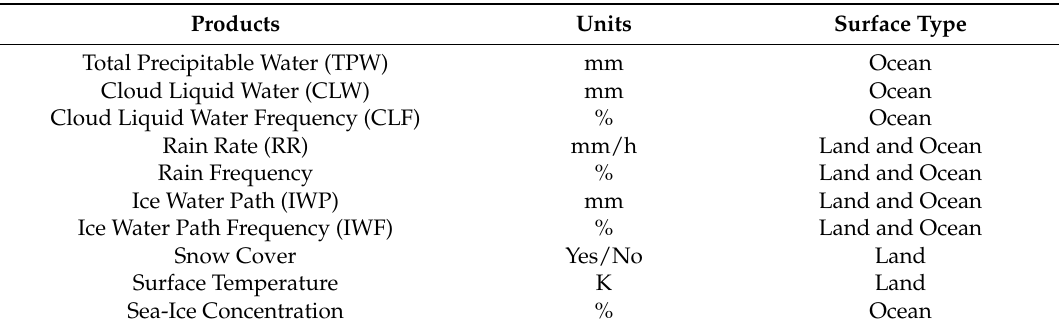
Table 3. AMSU-A/B/MHS L2 suite of